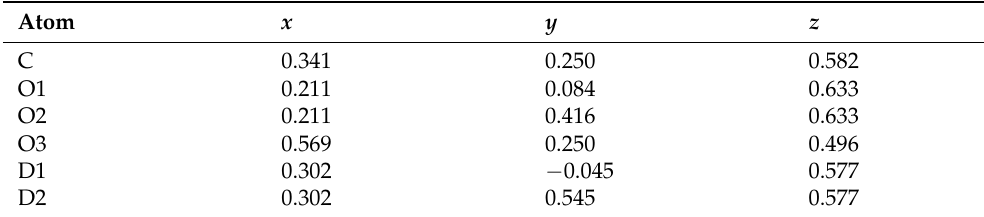
Table A3. DFT-optimized (PBE-D3) spatial parameters for deuterated carbonic acid at 2 GPa based on the experimentally refined crystal structure in space group P 2 1 / c ; a = 4.8787, b = 6.5089, c = 6.2482 Å, β = 93.14 ◦ ; see also